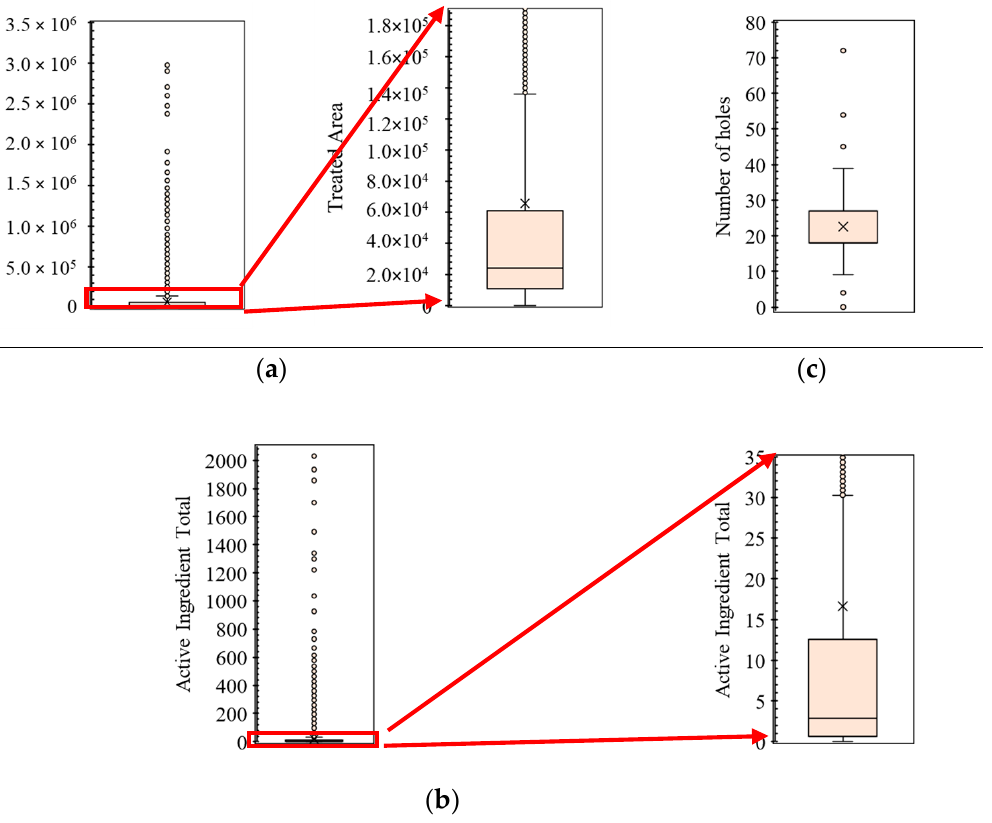
Figure 2. Box plots of the independent input and dependent output variables: ( a ) treated area (TA); ( b ) active ingredient total (AIT); ( c ) number of holes (NH).